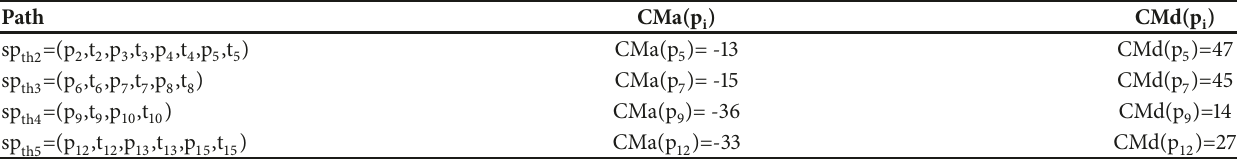
Table 1: Available control margin for an advance and for a delay associated with place p i . Path CMa(p i